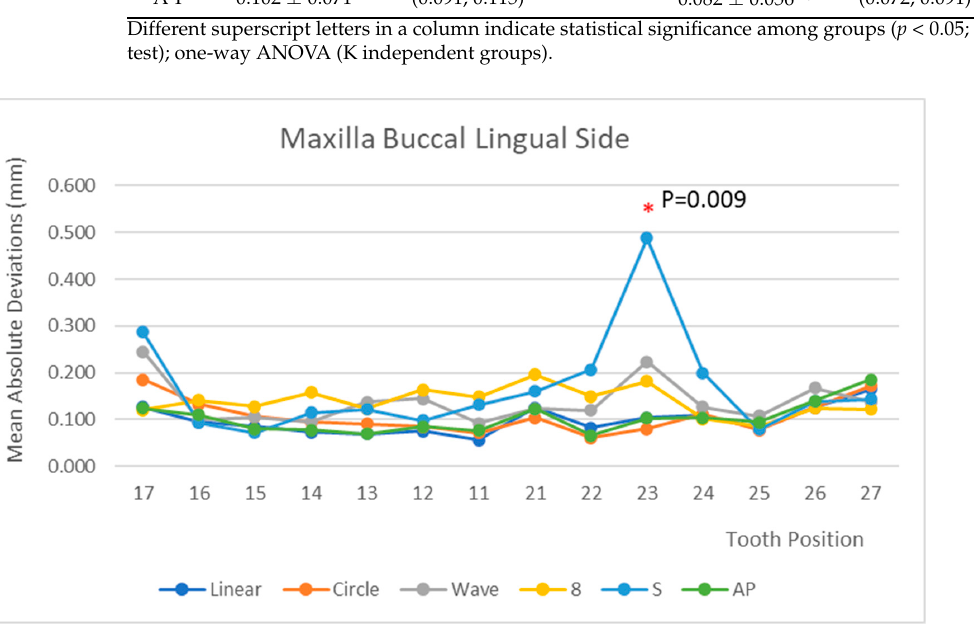
Figure 6. B-L deviations at different tooth positions among six head movements in the maxilla. * Statistically different at tooth position among six movements.